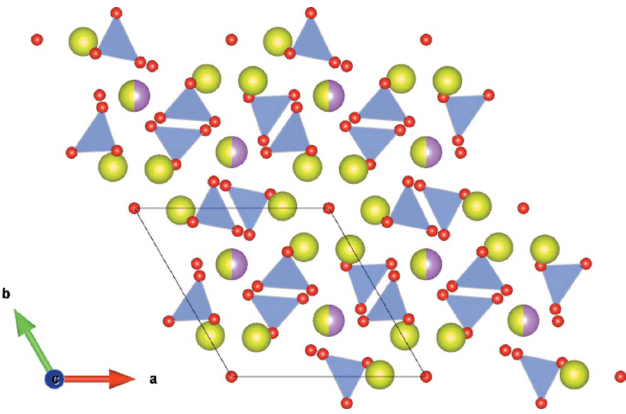
Figure 1 Polyhedral representation of the Ca 2 Ce 8 (SiO 4 ) 6 O 2 structure. SiO 4 tetrahedra are in blue, the mixed Ca/Ce sites are shown as pink/yellow and the Ce sites as yellow spheres,